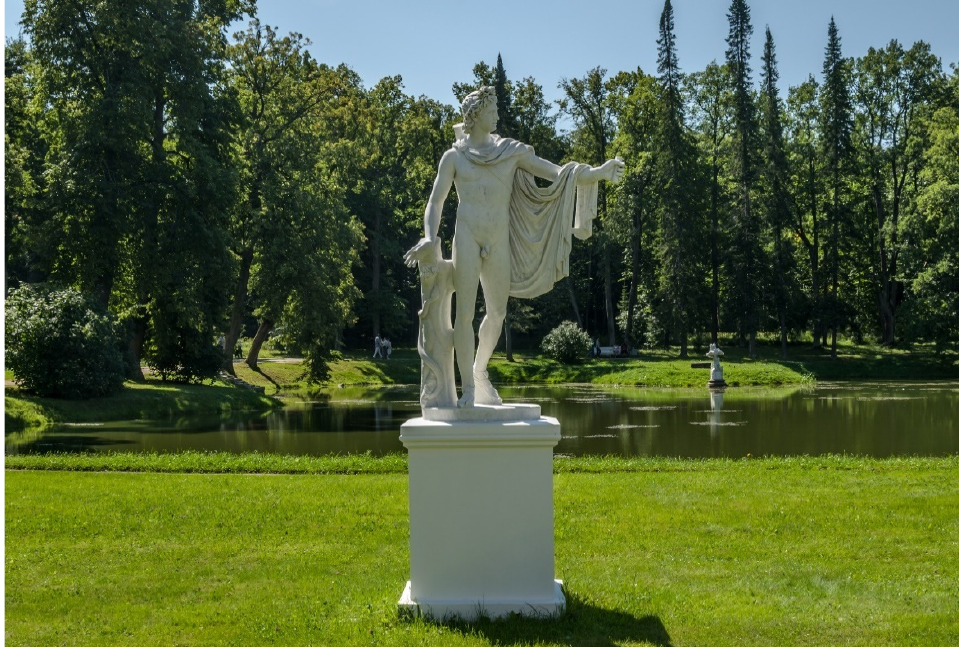
Figure 2. Apollo Belvedere (a marble copy). Oranienbaum, near Saint Petersburg. Last but not least, there were two copies in Pavlovsk park. One was the 1782 copy in bronze situated in the Twelve Paths area at the Old Sylvia (by Edme Gastecloux, after Gordeev’s cast; see Figure 3). The other was a plaster cast in the Apollo Colonnade, replaced by an iron cast in 1826 (Andreeva 2017, pp. 120, 128). More copies were made in or brought to Saint Petersburg in the 1820s or later. After WWII, they were all reinstalled in what is believed to be their original places.